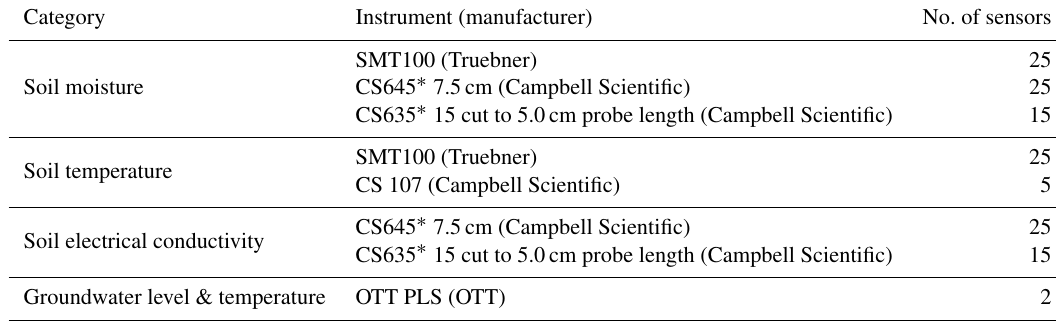
Table 1. Hydrological instrumentation at AGGO. Category